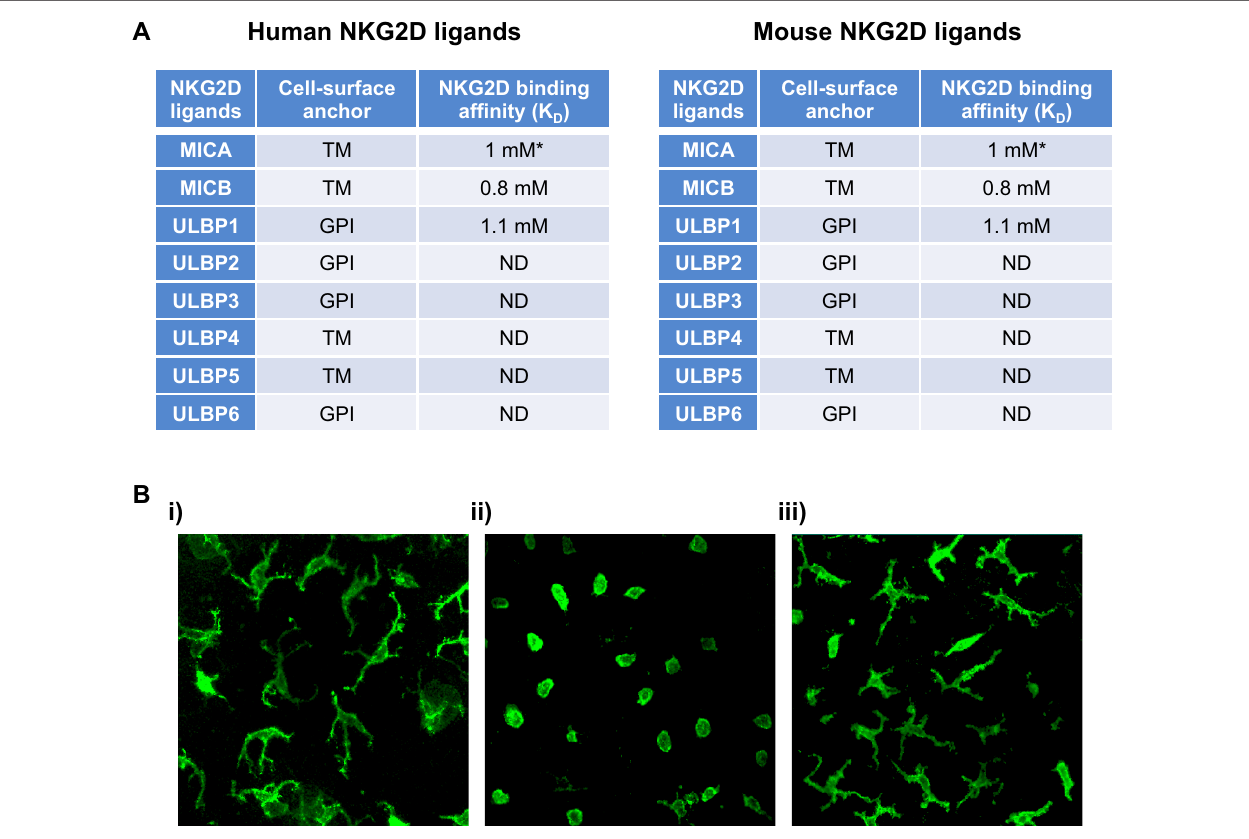
FiGURe 1 | NKG2D ligands and a timely response to alteration in their expression by epidermal γδ TCR + intraepithelial lymphocytes (IELs). (A) Human and mouse NKG2D ligands, their cell surface anchor and their affinity to NKG2D are shown. (B) Representative confocal images of murine epidermal V γ 5V δ 1 + lELs in whole epidermal sheets following transgenic upregulation of Rae-1 under the involucrin promoter. (i) Single-transgenic and (ii) bi-transgenic mice were fed with doxycycline for 72 h, inducing expression of Rae-1 only in bi-transgenic mice (4). (iii) Mice with sustained expression of Rae-1 under the involucrin promoter (19). The images depict how acute expression of Rae-1 on epithelial cells induces morphological and activational changes in the neighboring IELs, whereas constitutive expression of Rae-l renders them hyporesponsive. Abbreviations: *allele-dependent NKG2D, natural killer group 2 member D; MIC, MHC class I-chain-related protein; ULBP, cytomegalovirus UL16-binding protein; Rae-1, retinoic acid early-inducible 1; MULT1, murine UL16-binding protein-like transcript 1; al, a2, and a3, analogous to the a1, a2, and a3 domains of MHC 1a proteins; TM, transmembrane protein; GPl, glycosylphosphatidylinositol-linked protein; ND, not